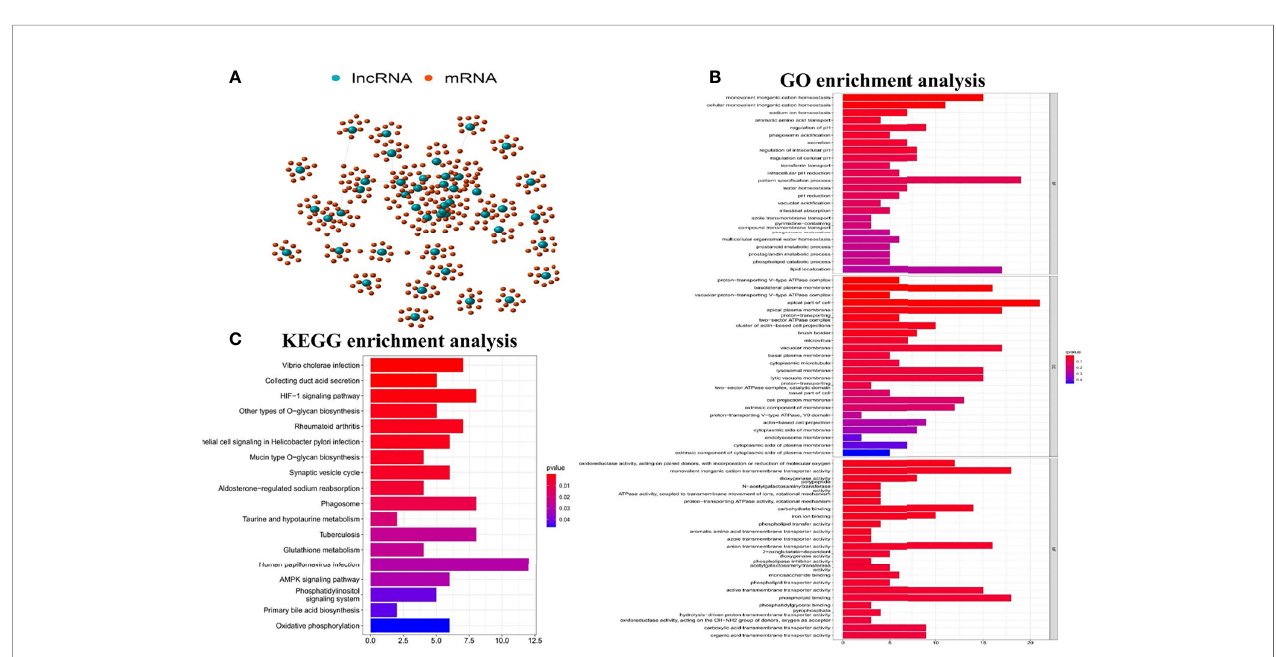
FIGURE 2 | Functional analyses of the GInLncRNAs. (A) The relationship networks between GInLncRNAs and their top 10 co-expressed protein-coding genes were constructed according to Pearson correlation coef fi cient. The GInLncRNAs and protein-coding mRNAs were represented by blue and orange circles, respectively. (B) Barplot of GO enrichment analysis of protein genes co-expressed with the GInLncRNAs(P<0.05). (C) Barplot of KEGG enrichment analysis of protein genes co- expressed with the GInLncRNAs